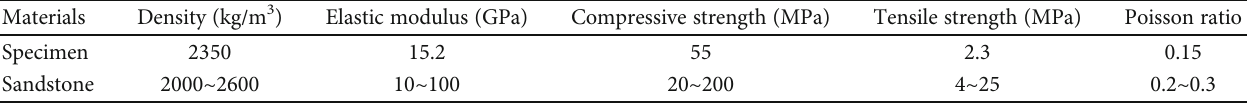
Figure 7: Testing of prefabricated specimen mould and specimen Table 4: Mechanical parameters of intact specimen and sandstone.